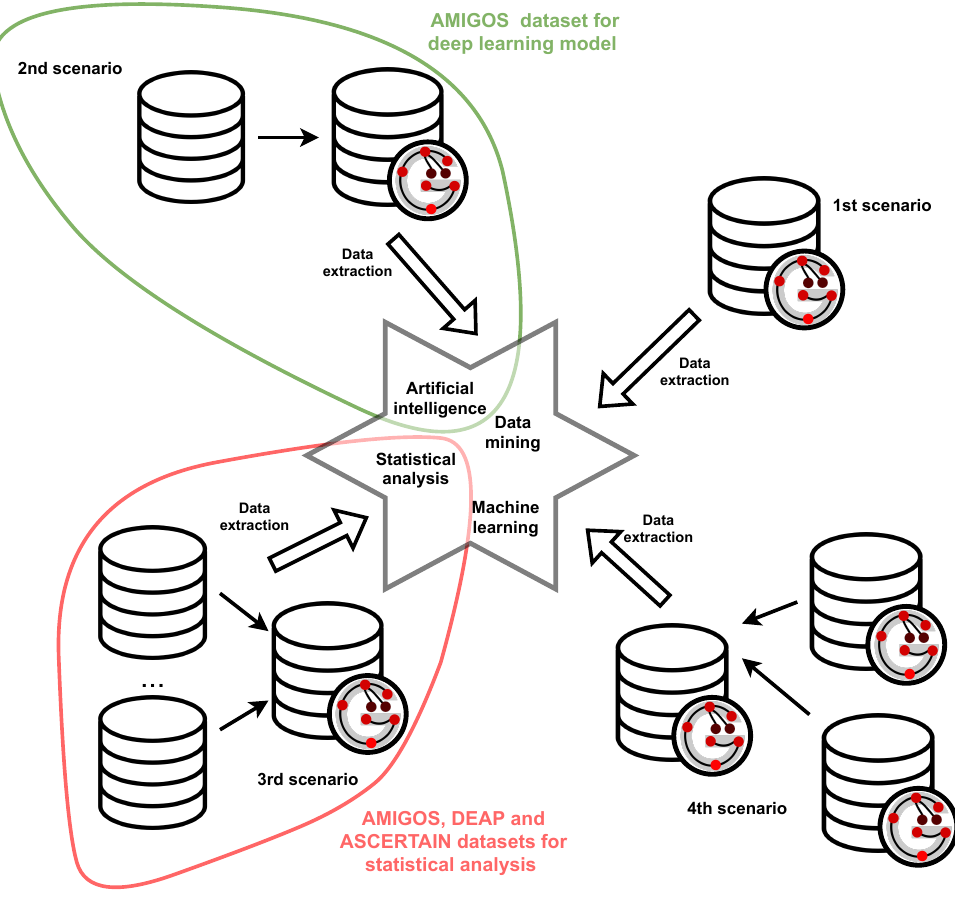
Figure 1. Application of GRISERA